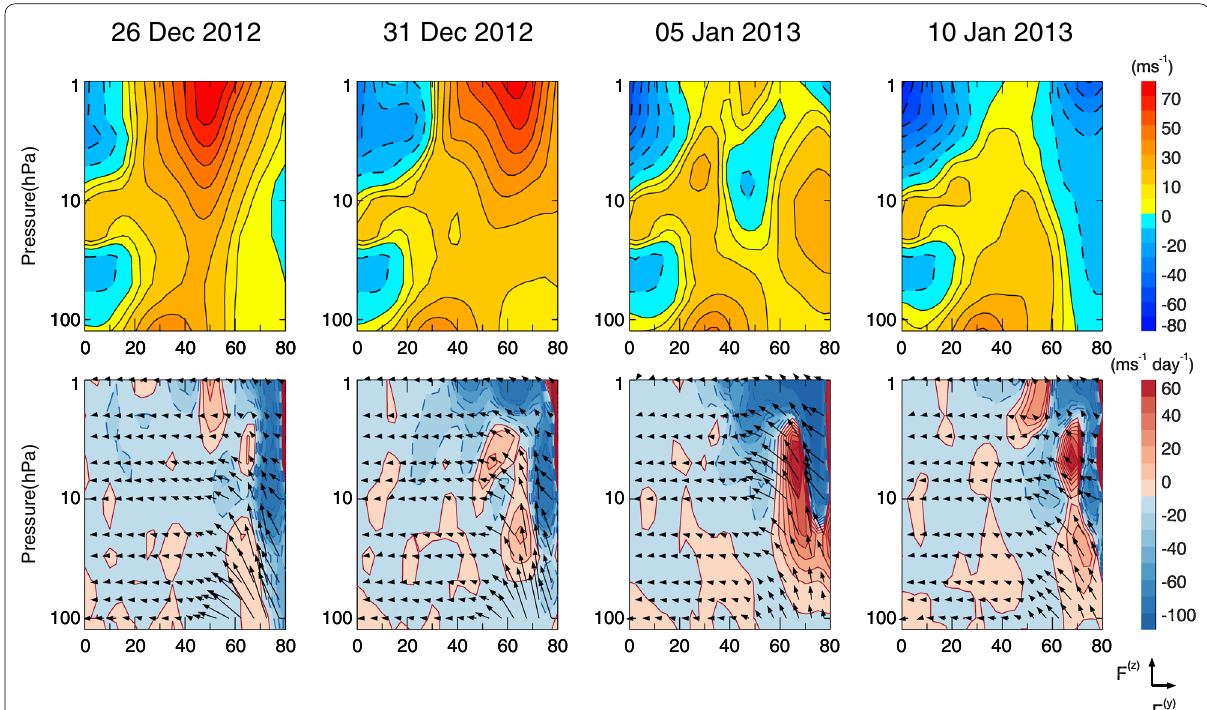
Fig. 12 Altitude versus latitude structures of zonal-mean zonal winds (top), EP flux F (vectors) and D F (color shading) from W1-SPW1 (bottom)